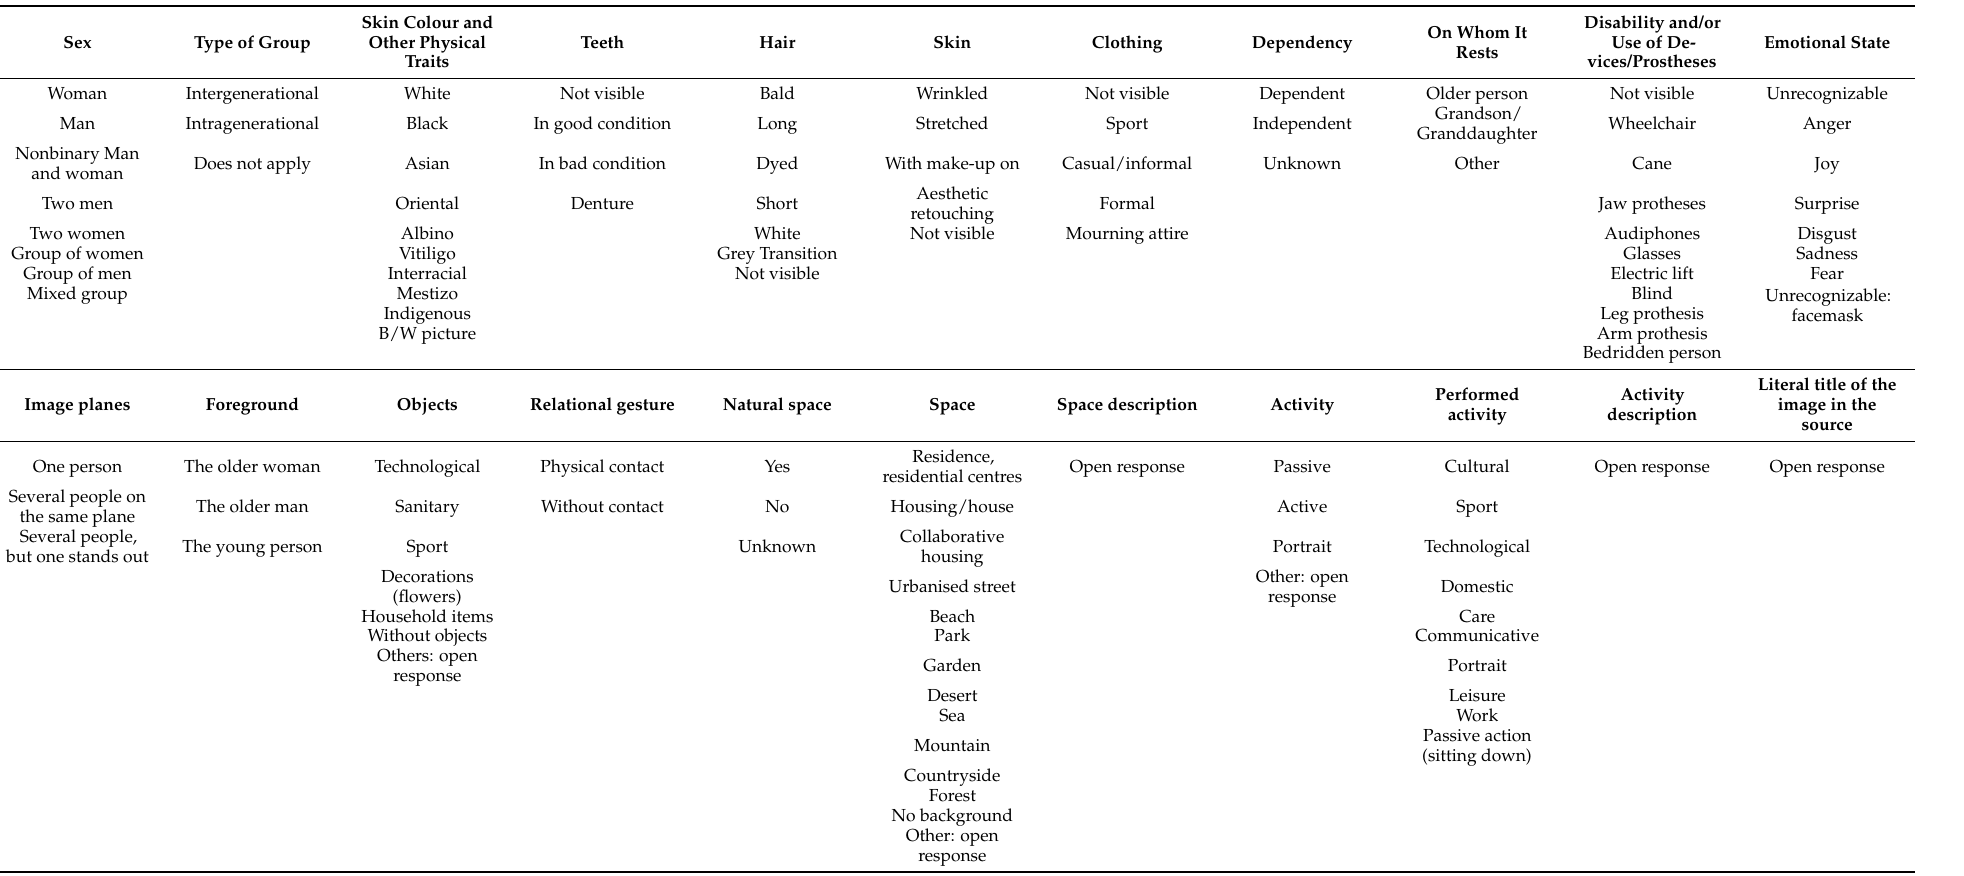
Table 1. Variables used for image evaluation (n = 150